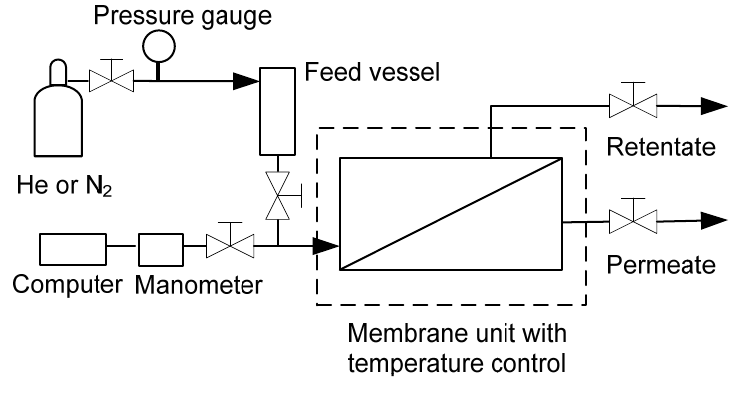
Figure 6. Schematic diagram of the gas permeation